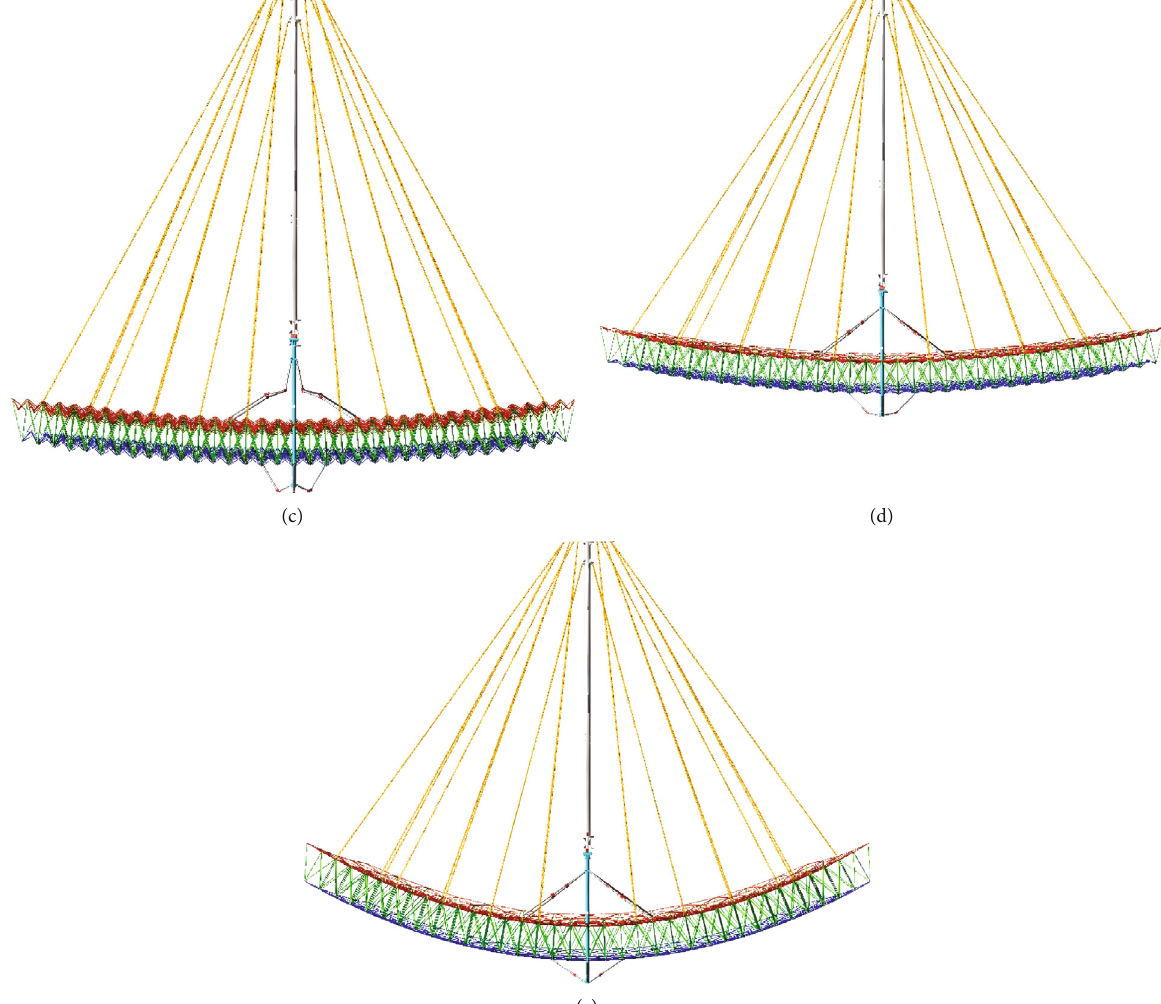
Figure 10: The simulation of re fl ector deployment process. (a) Deployed process 1. (b) Deployed process 2. (c) Deployed process 3. (d) Deployed process 4. (e) Deployed process